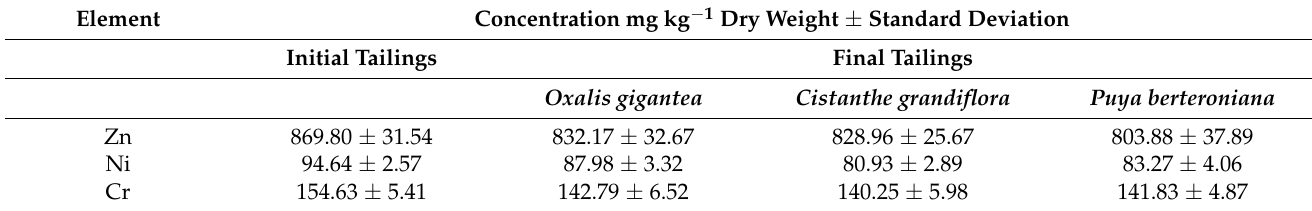
Table 2. Initial and final concentrations of elements in tailings ± standard deviation.